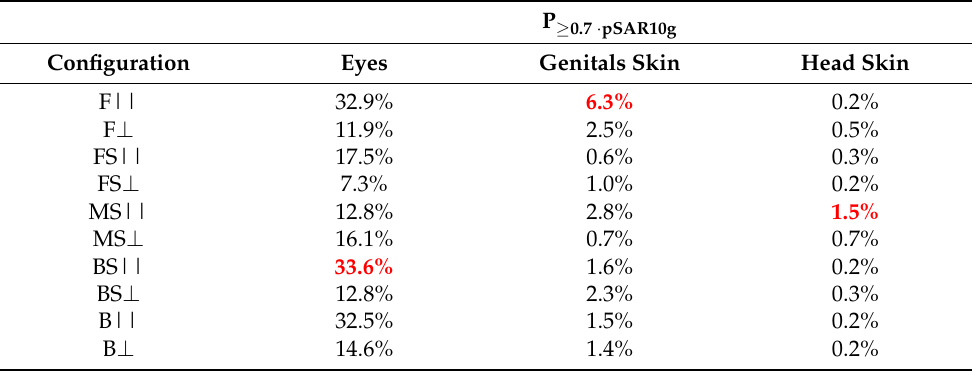
Table 2. P ≥ 0.7 · pSAR10g for the eyes and the skin at the genitals and head areas across the 10 con- figurations of the human model. The red text highlights the highest P ≥ 0.7 · pSAR10g values for each